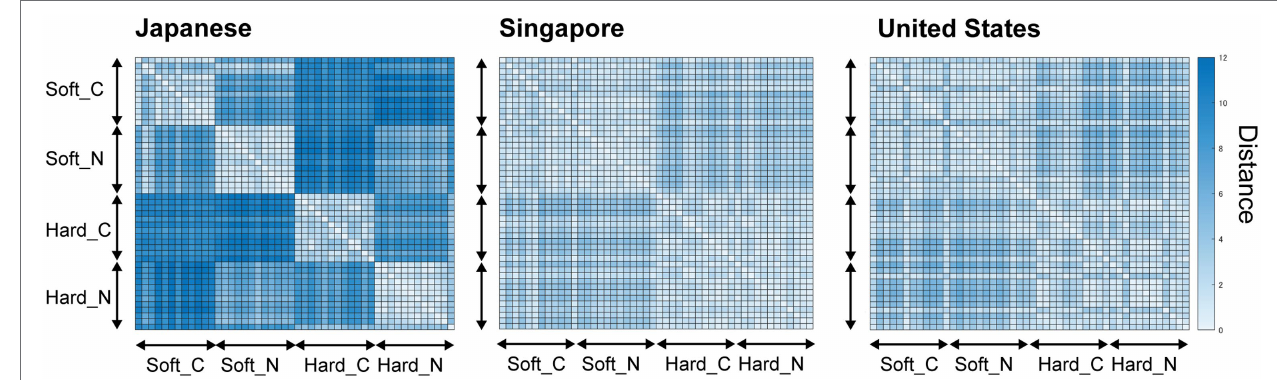
FIGURE 4 | Dissimilarity matrices for the 48 sound-symbolic words. We calculated the Euclidean distance between each pair of words employing the ratings of four dimensions (hardness, warmth, roughness, and familiarity). Horizontal and vertical axes indicate the list of words shown in Table 2 . Soft_C, Soft_N, Hard_C, and Hard_N indicate the conventional softness, novel softness (generated by GA), conventional hardness, and novel hardness words, respectively. Each pixel indicates the difference between the distance of the words (the higher the distance, the bluer the pixel looks). The order of the words in each category (from top to bottom) is the same as the order of the words in Table 2 . Since the orders of the words were the same along the horizontal and vertical axes, a symmetrical matrix was obtained.